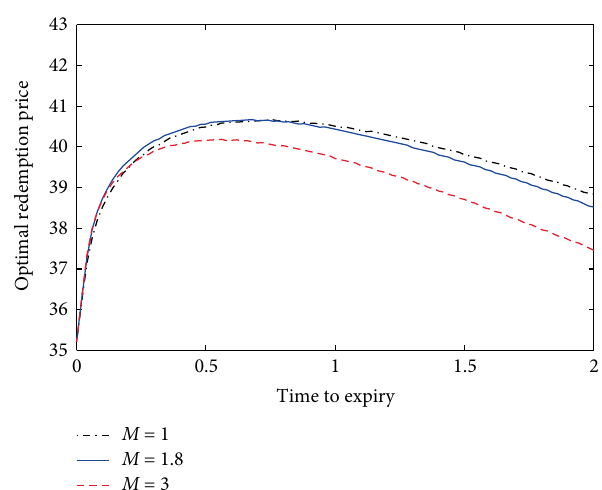
Figure 10: Optimal redemption prices with 𝐶 = 0.03,𝐺 = 1.2, 𝑌 = 1.5, 𝑇 = 2,𝐾 = 50